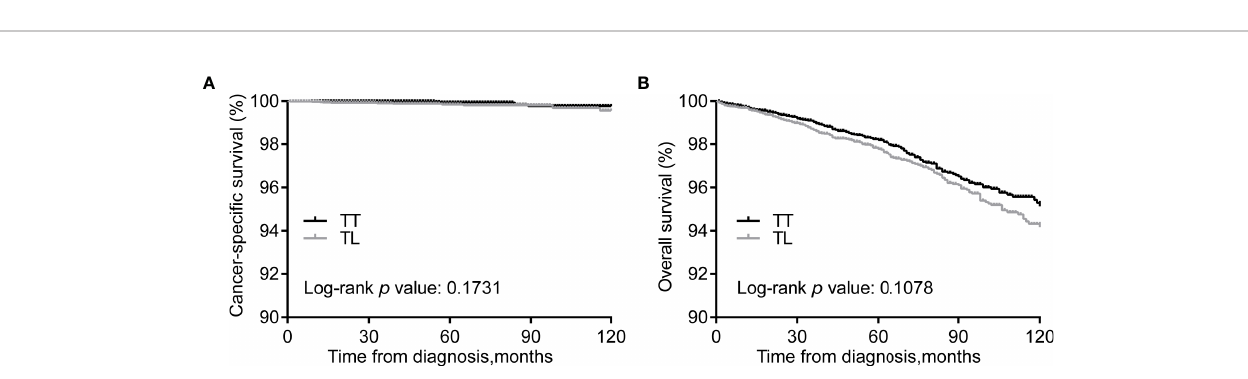
FIGURE 2 | Kaplan-Meier curves of CSS (A) and OS (B) of PTMC patients undergoing TT versus TL after propensity score matching. CSS, cancer speci fi c survival; OS, overall survival; PTMC, papillary thyroid microcarcinoma; TT, total thyroidectomy; TL, thyroid lobectomy.